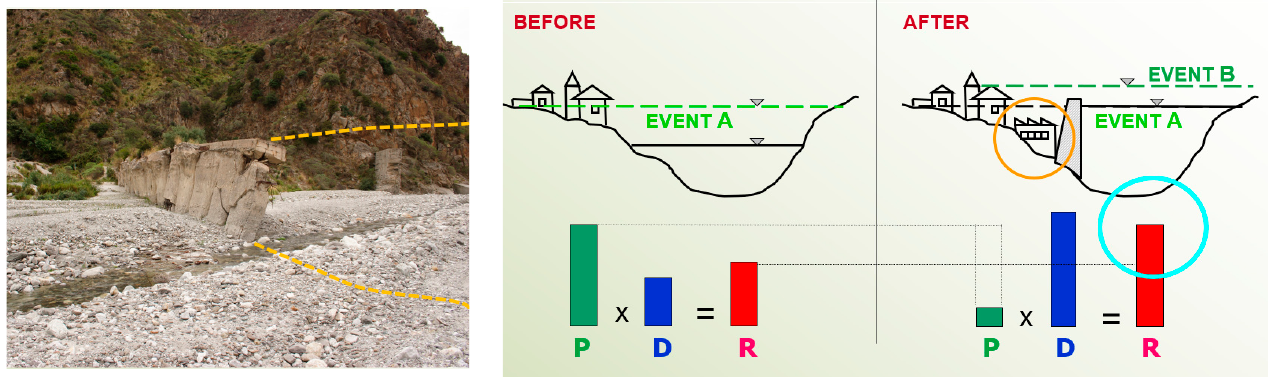
Figure 2. ( Left ): Evidence of two failed big weirs originally conceived to control downstream aggradation: a stout, but fragile, solution; ( Right ): The paradox of putting a system in safe conditions leading to an increase in risk with respect to the original situation (BEFORE sketch) because people, feeling safe after the protection works (the longitudinal dike in the AFTER sketch), inevitably increase exposed value (golden circle and higher blue D bar of potential damage; not in scale); but an event higher than the design one (Event B higher than Event A) is perfectly possible, although with a lower occurrence probability (P); Risk (R), a combination of probability P and damage D, has hence grown. Moreover, “forgetting the river” deletes the awareness of the risk problem as well as that of a socially, environmentally and economically very valuable